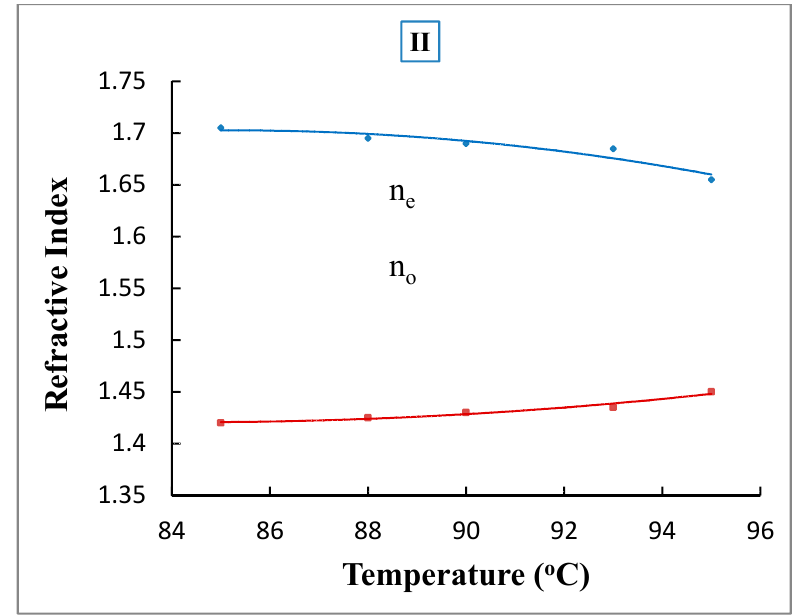
Figure 7. Dependence temperature of refractive indices ( (cid:4) ) n o and ( (cid:7) ) n e for compound II at 543 nm.